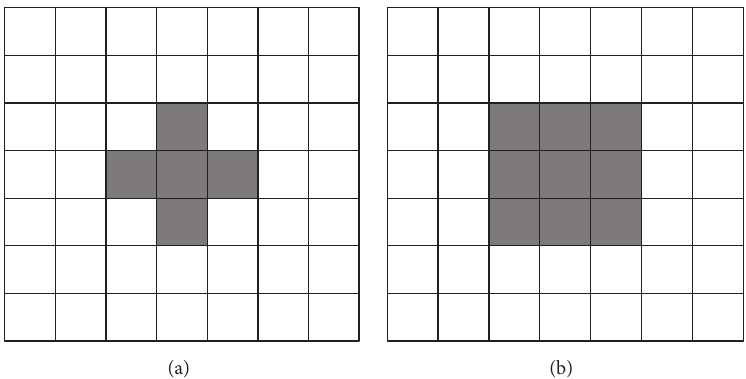
Figure 2: Pixels highlighted in (a) 4-connected neighborhood and (b) 8-connected neighborhood around a chosen central pixel.